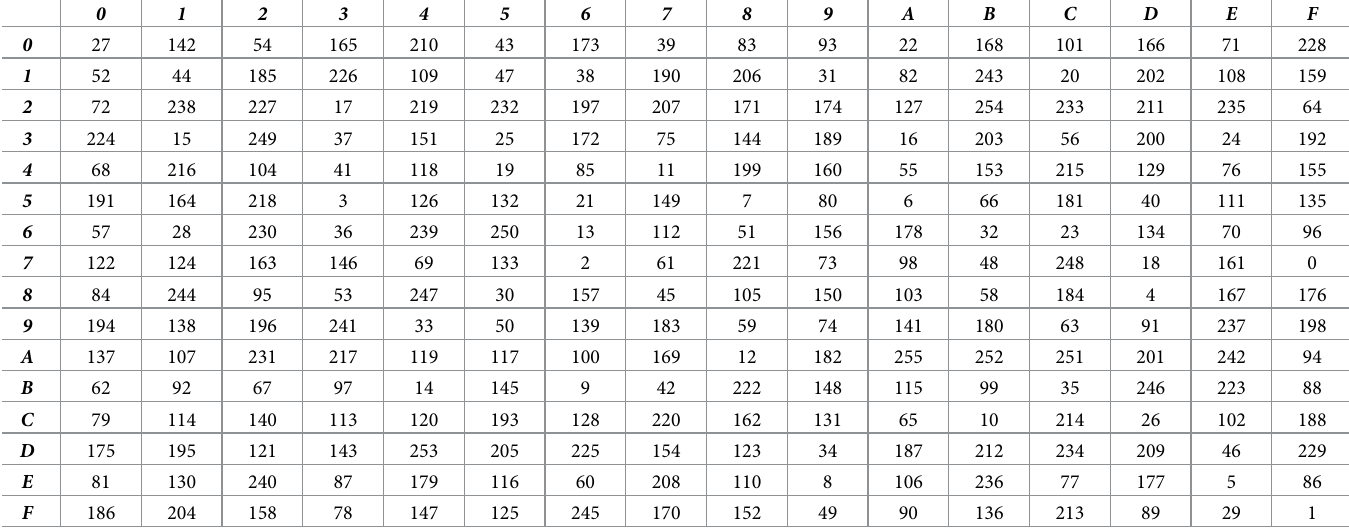
Table 7. Proposed S-box (S6) in 16 × 16 matrix form—Generated with T 6